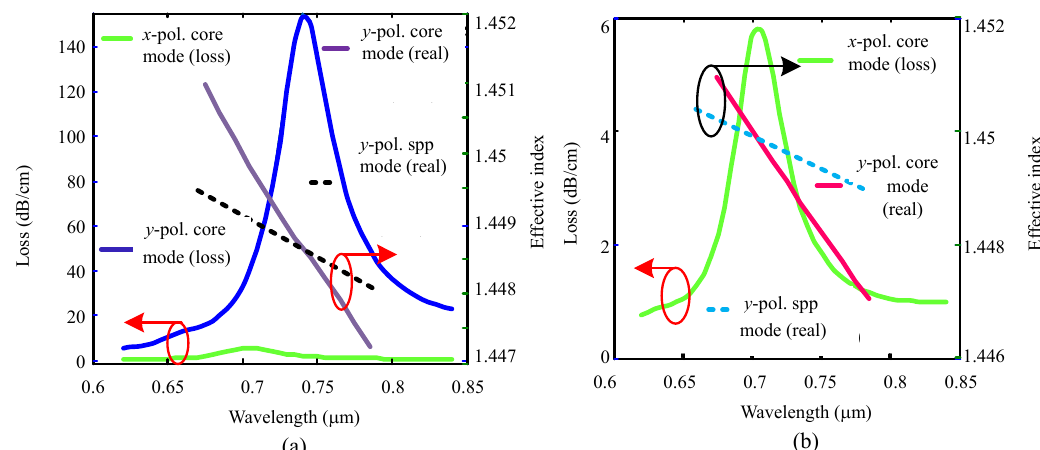
Fig. 4 Dispersion relationship of core guided and plasmonic modes for: (a) y- and (b) x- polarization modes for analyte RI of 1.38.